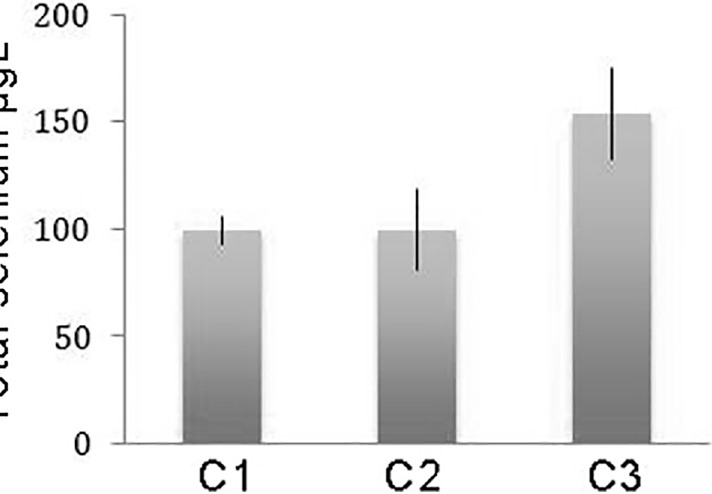
Fig 3. Total Se content in sheep blood. Tests for total Se content were performed in the blood of sheep that were exposed to diets featuring different: C1, C2, C3. Each value corresponds to the mean calculated from 5 biological replicates ±